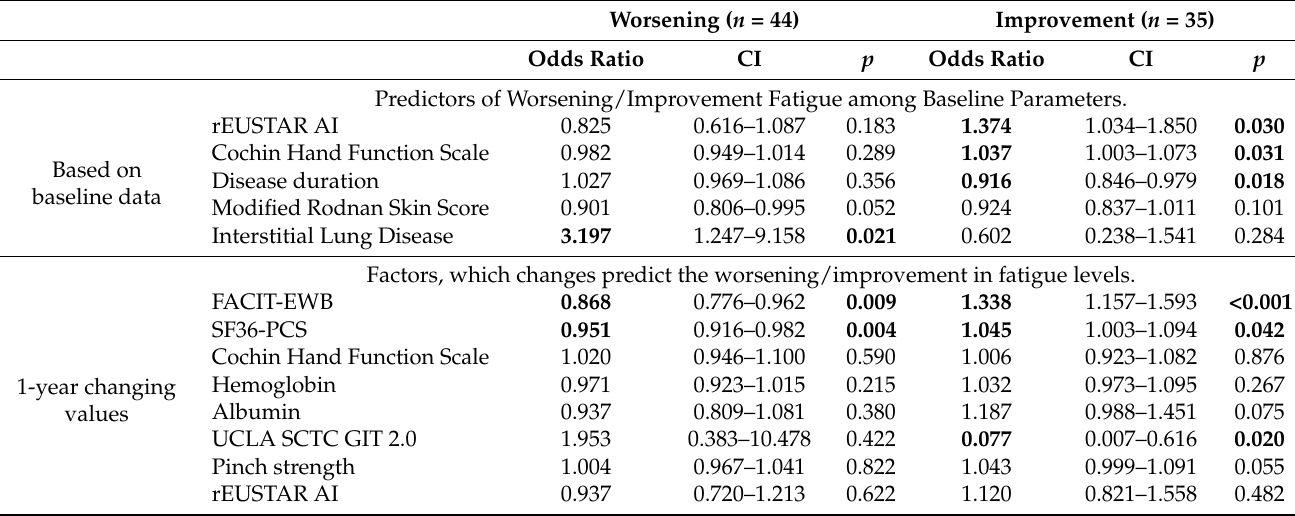
Table 4. Predictors of alterations in levels of fatigue during 12-month follow-up selected with Random Forest algorithm (Figure 2) in 144 followed (44 worsened, 35 improved, 65 unchanged regarding fatigue) patients with systemic sclerosis using binary logistic regression analyses. Worsening ( n = 44) Improvement ( n = 35) Odds Ratio CI p Odds Ratio CI p Predictors of Worsening/Improvement Fatigue among Baseline Parameters.